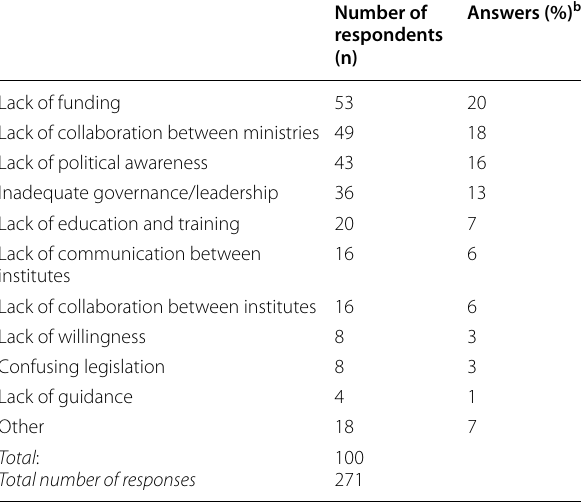
implementation of One Health